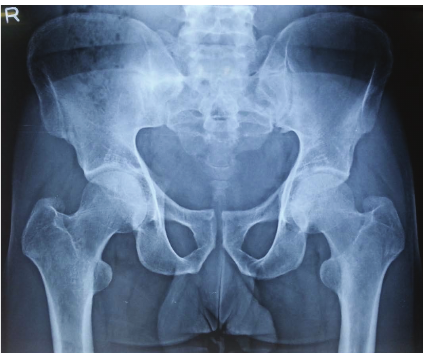
Figure 1: Plain radiograph of bilateral hip joint with pelvis demon- strating a faint fracture line in the left femur neck and no fracture line in the right femur neck.